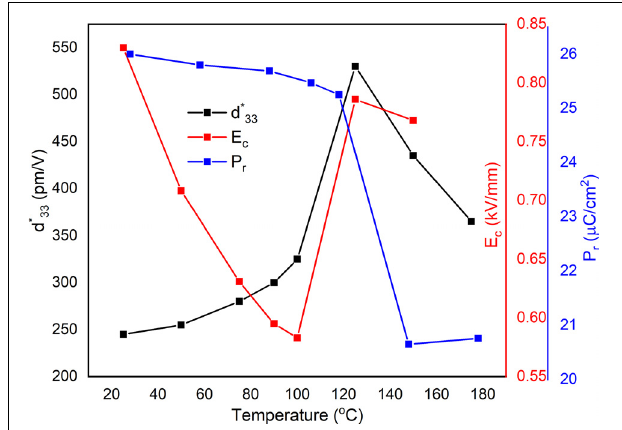
FIGURE 11 | d ∗ 33 , E C , and P r of x = 1 mol.% as a function of temperature.